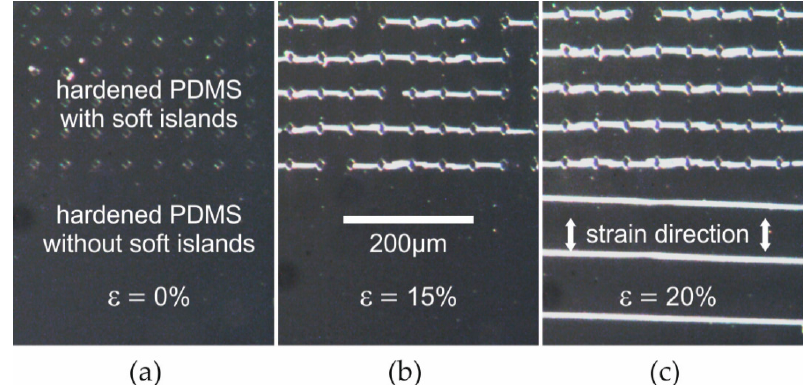
Figure 2. Optical micrographs of PDMS surface treated with UV (30 J ∙ cm − 2 ): top area: including untreated soft islands (distance of 45 μ m), bottom area: homogeneously ‐ hardened; micrographs taken after application of strain (direction shown in c) of 0% ( a ); 15% ( b ); and 20% ( c ).